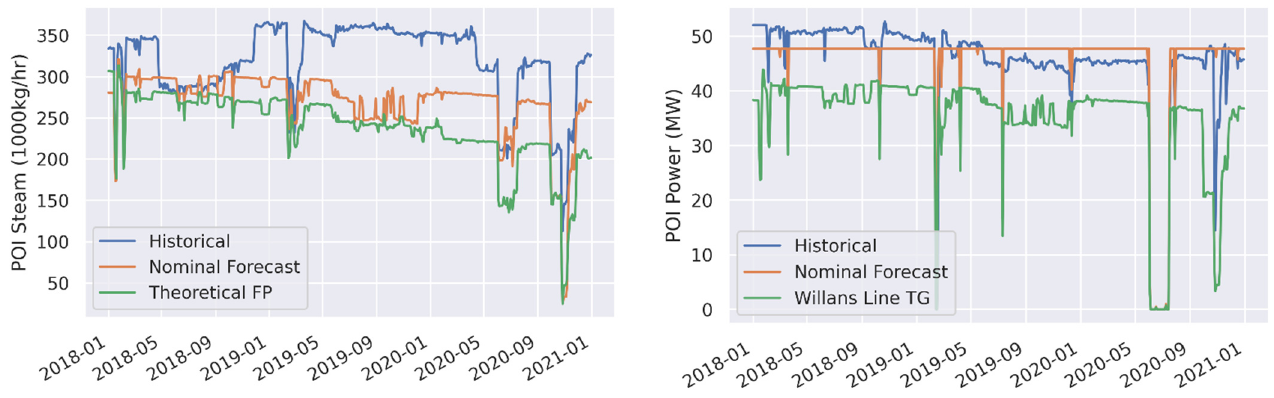
Figure 8. Binary plant power generation, comparing historically measured data versus the nominal forecast model (including the binary plant multi-linear regression model).